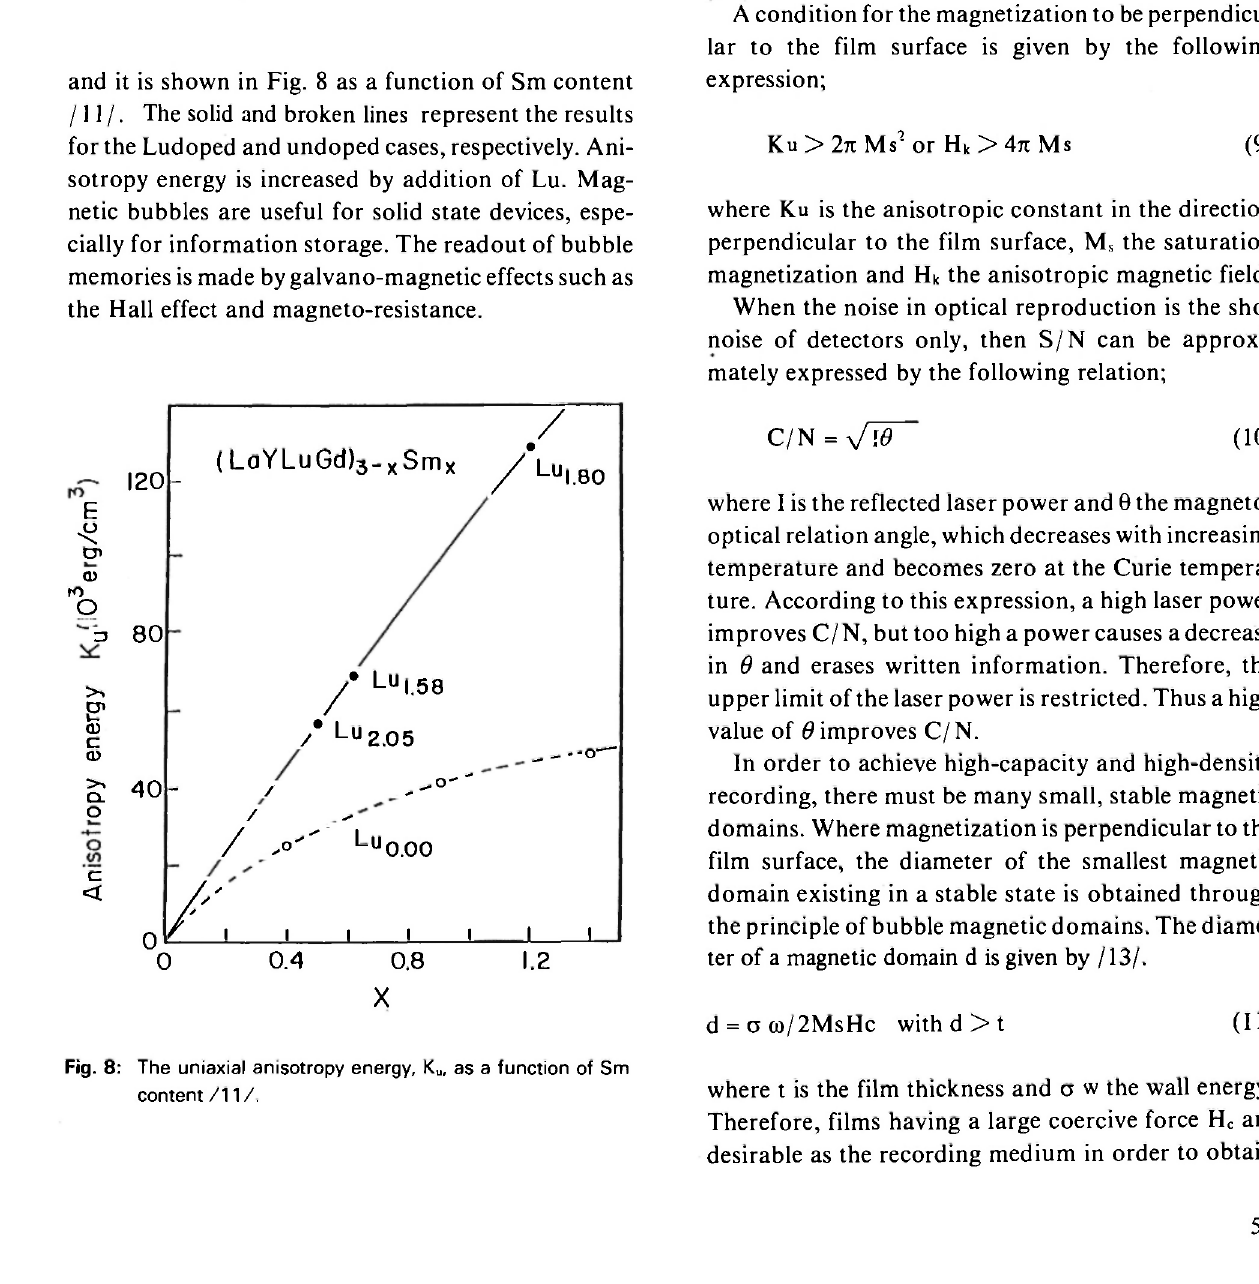
Fig. 8: The uniaxial anisotropy energy, K„, as a function of Sm content